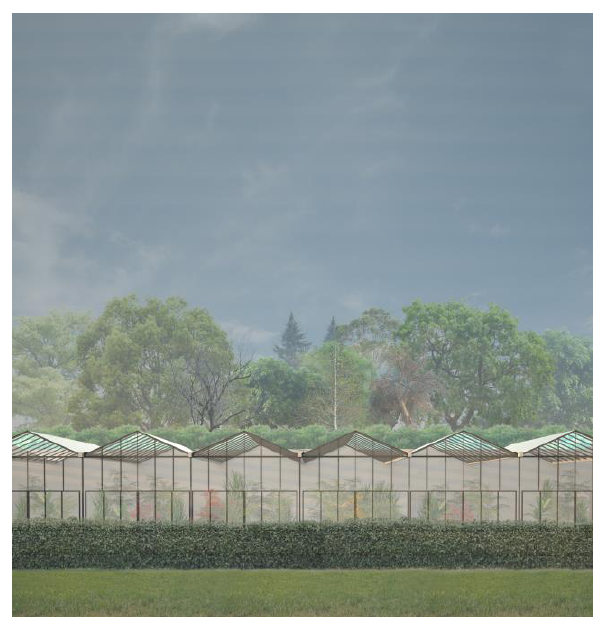
Figure 15. The Royal Park of Tirana. Render of